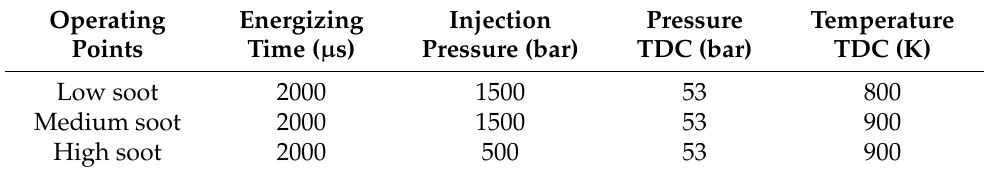
Table 3. Main characteristics of the operating points.